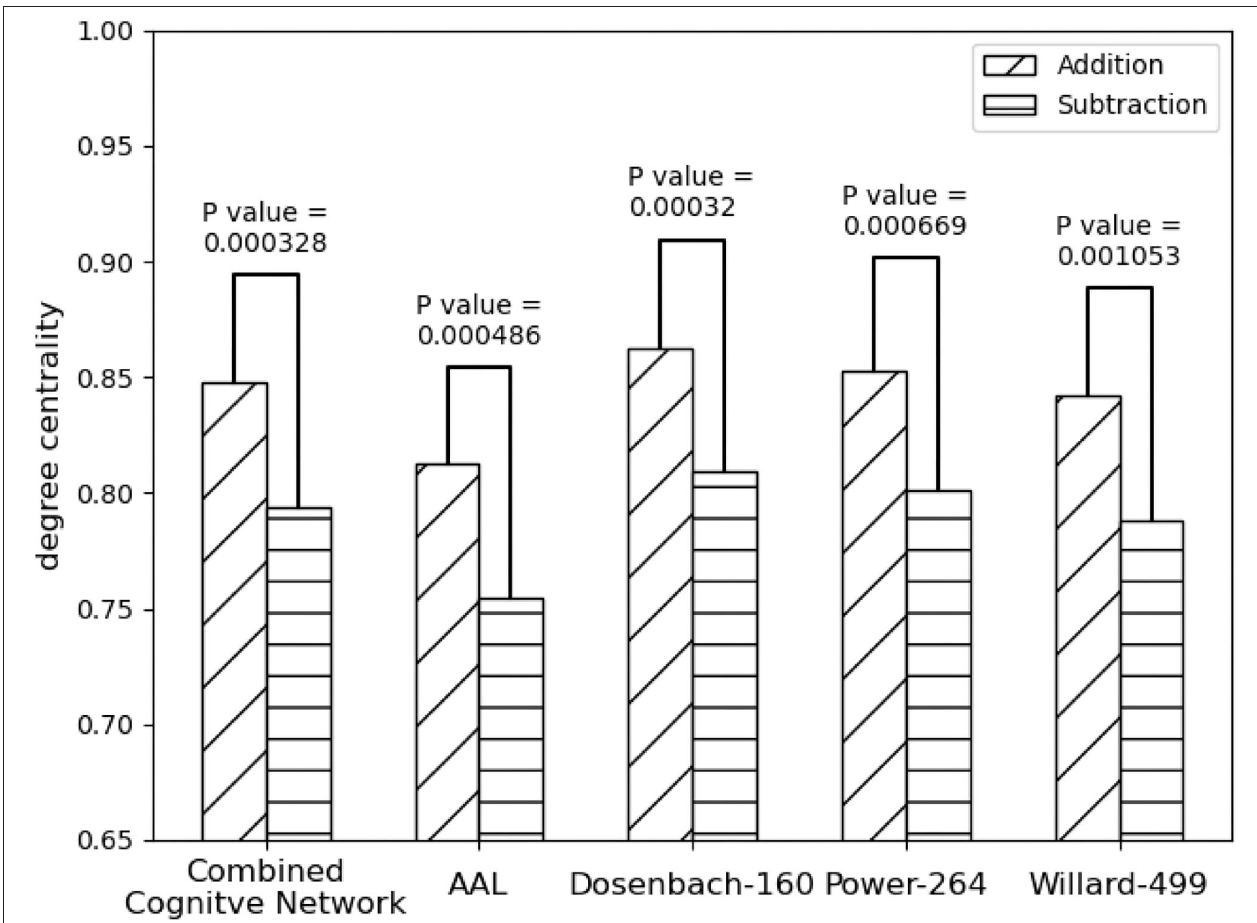
FIGURE 5 | Statistical comparison results of the FPNs’ topological property (degree centrality) between the addition and subtraction cognitive states. The FPN of Dosenbach-160 has yielded the sharp differences with the biggest statistical significance between the two cognitive states of mental arithmetic, followed by the FPNs of CCN (Combined Cognitive Network), AAL, Power-264, and